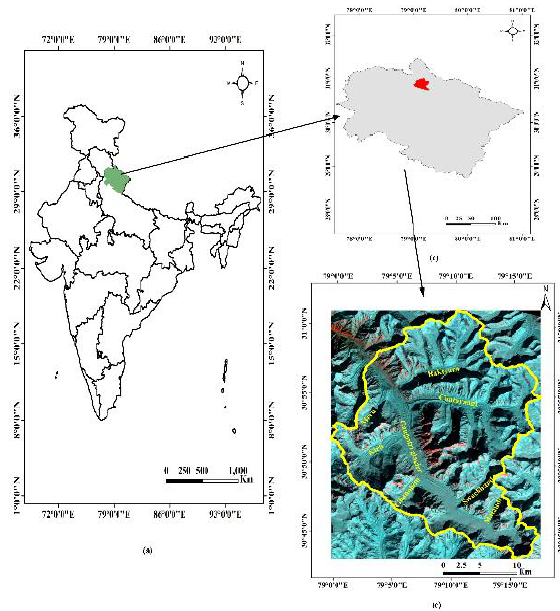
Figure 1. Study area (a) Map of India (b) Map of Uttarakhand with Gangotri basin boundary (red color) (c) Standard FCC of Gangotri glacier with tributary